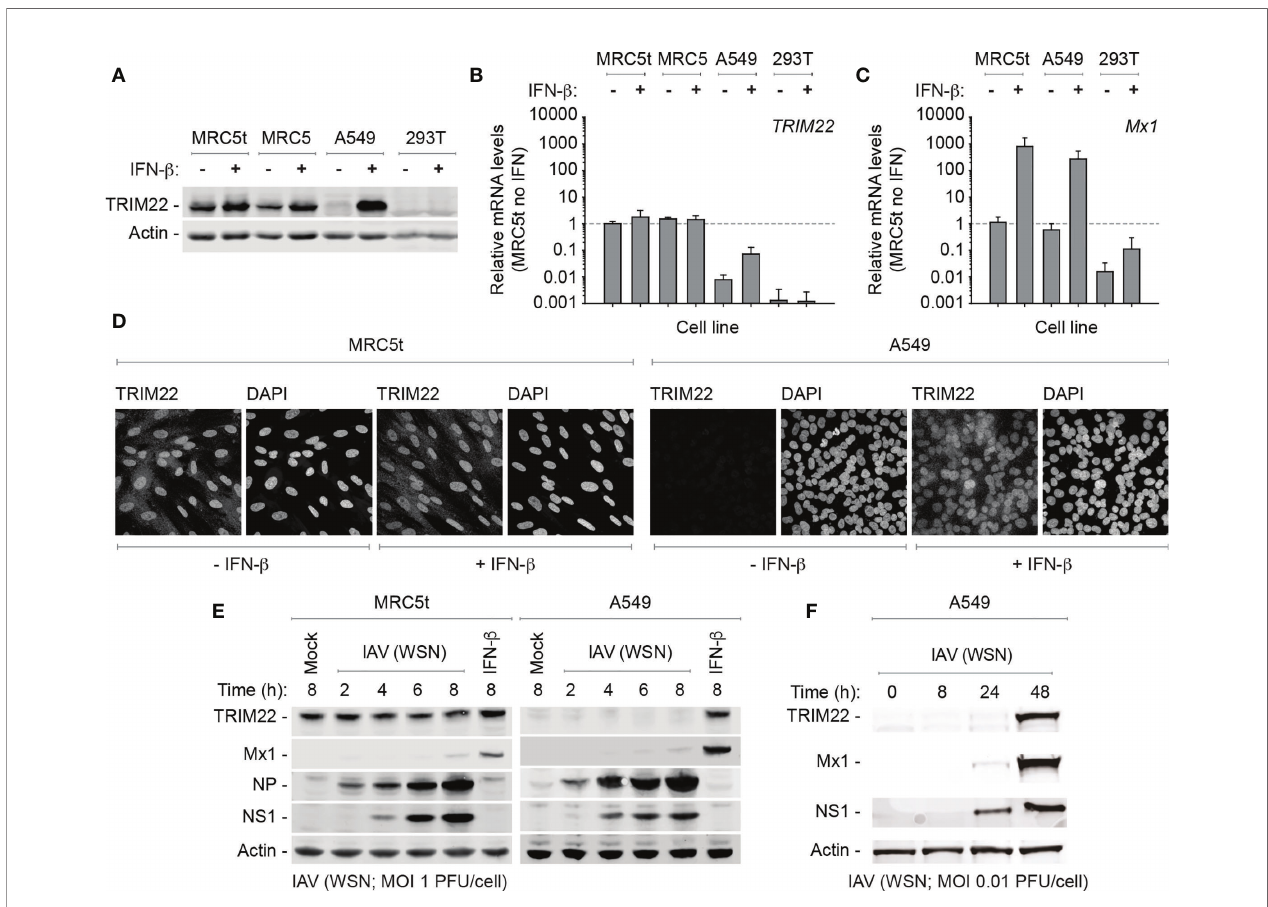
FIGURE 3 | TRIM22 is differentially expressed in a cell-type dependent manner. (A – C) Primary and hTERT immortalized human lung fi broblast (MRC5 and MRC5t, respectively), lung adenocarcinoma epithelial (A549), and SV40-transformed human kidney epithelial (HEK 293T; 293T) cells were treated with (+) or without (-) IFN- b (100 IU/ml) for 24 h. (A) Western blots of WCLs probed for TRIM22 expression. Actin is shown as a loading control. (B, C) qRT-PCR quantitation of TRIM22 and Mx1 mRNA transcript expression levels, respectively. Values normalized to MRC5t cells without IFN treatment (dotted line); n=3, means and SD shown. (D) Confocal microscopy images of MRC5t and A549 cells with or without IFN treatment (as in A ). TRIM22 was labelled by indirect immuno fl uorescence. Nuclei were stained with DAPI. (E) MRC5t and A549 cells were mock-treated, IFN- b (100 IU/ml) stimulated or infected with IAV (A/WSN/1933(H1N1), WSN) at a MOI of 1 PFU/cell (based on MDCK titres) for the indicated times (hours; h). WCLs were analyzed by western blots for TRIM22, Mx1, and viral protein (NP and NS1) expression. Actin is shown as a loading control. (F) A549 cells were infected with IAV (WSN; MOI of 0.01 PFU/cell based on MDCK titres) and harvested at the indicated times prior to western blotting (as in E